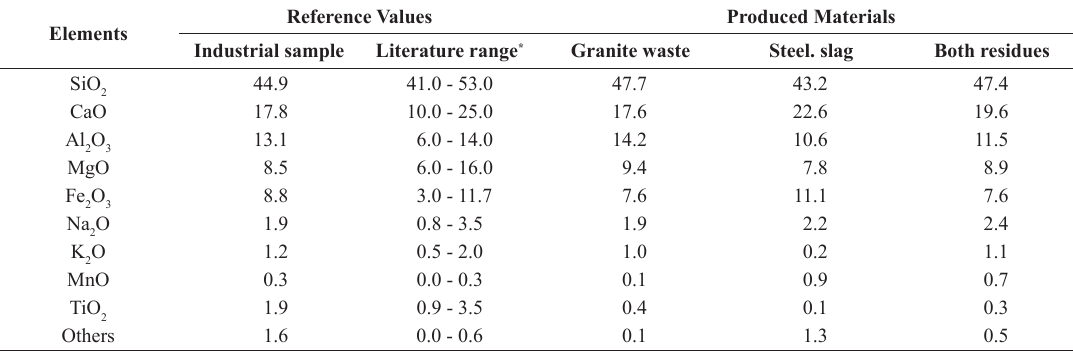
Table 2. Comparison of chemical compositions of rock wool samples: Industrial wool, literature range and produced materials sorted by each applied residue (in wt. %). Reference Elements